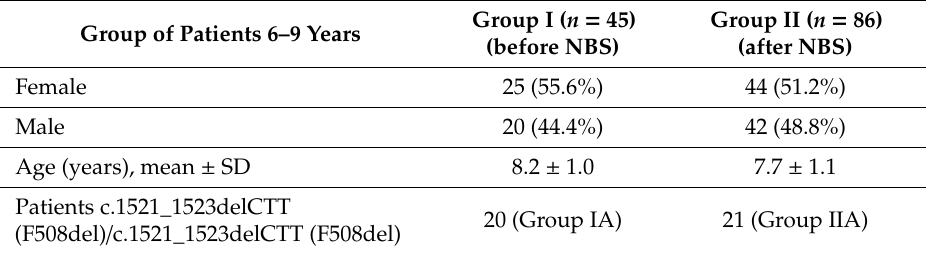
Table 1. The characteristics of the patient